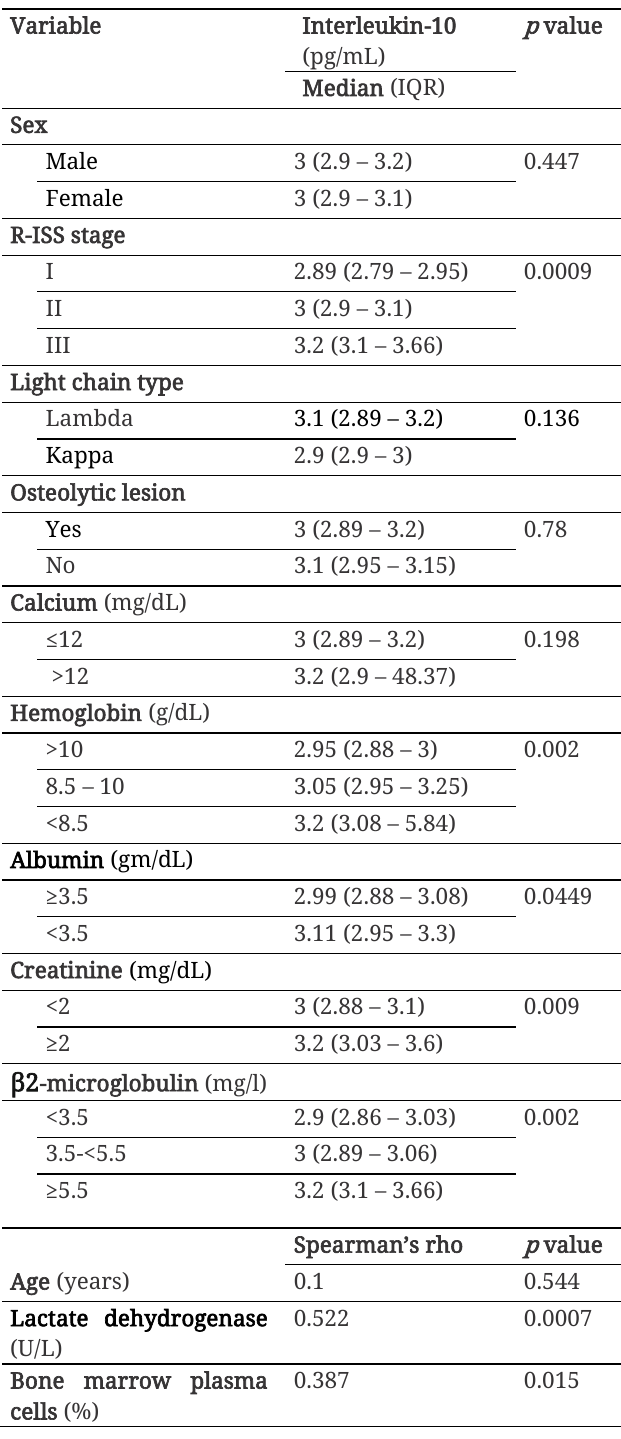
Table 2: Correlation between interleukin-10 level and the studied